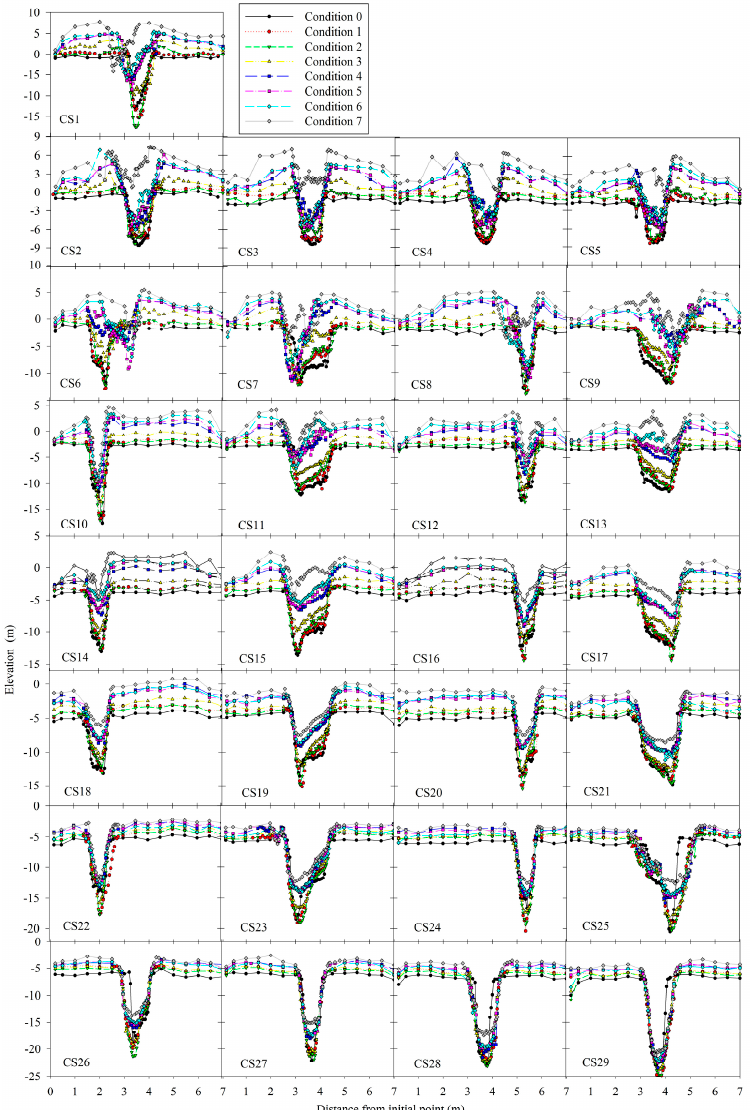
Figure 6. Topographic changes of each section: CS1–CS5, front riverine beach without vegetation and a straight compound channel section; CS6–CS9, with no vegetation and a meandering compound channel area on the riverine beach; CS10–CS13, the convex bank of the riverine beach with vegetation and a meandering compound channel area; CS14–CS17, the riverine beach concave bank with vegetation and a meandering compound channel area; CS18–21, with vegetation and a meandering compound channel area on both sides of the riverine beach; CS22–CS25, the flat land covered with vegetation and meandering compound channel areas; CS26–CS29, after the riverine beach without vegetation and a straight compound channel area.